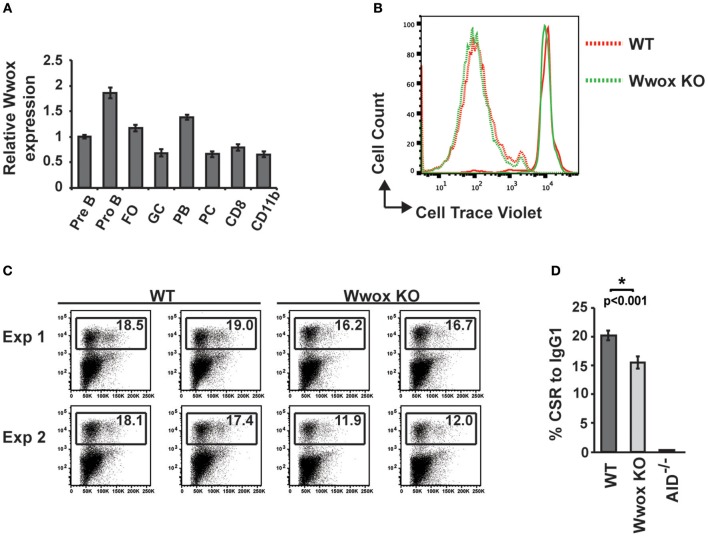
Wwox B cell expression and function during Ig class-switching. (A) Wwox transcript level analysis at various B cell differentiation stages. Pre B (B220+/CD43lo/IgM−), Pro B (B220+/CD43hi/IgM−), follicular ([FO], B220+/CD19+/CD23hi/CD21lo), germinal center ([GC], CD19+/GL7+/CD95+), Plasmablast ([PB], B220+/CD138+/CD19lo), and Plasma cell ([PC], B220−/CD138+/CD19−) B cells; CD8+ T cells; and CD11b+ populations were FACS sorted from the spleen or bone marrow of unimmunized wild-type mice. Relative levels of Wwox were assessed by RT-qPCR (Taqman assay) and normalized to 18S RNA levels. Results shown are mean values of triplicate analyses (error bars SEM). (B) Representative histogram of B cells proliferation analysis. Fluorescent intensity of baseline labeling (solid lines) of naïve B cells isolated from Wwox WT or Wwox KO spleens and after 72 h culture with IL4 and LPS (dotted lines). (C) Representative flow cytometry plots of CSR to IgG1 after 72 h culture. Relative percentage of cells expressing IgG1 is indicated on each plot. Duplicate plots from two experiments displayed. (D) Mean values of CSR to IgG1 in activated B cells from n = 4 independent experiments, (error bars SEM). P value was determined by a two-tailed t-test assuming unequal variance, * indicates significant p value.